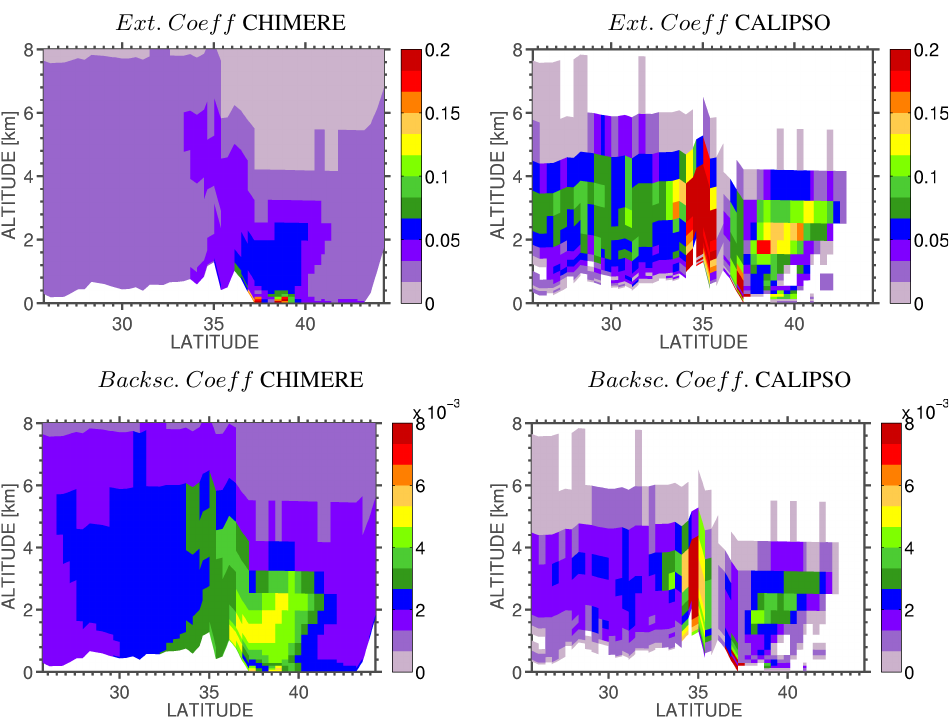
Fig. 13. Extinction (km − 1 ) and backscatter (km − 1 sr − 1 ) coefficient by CHIMERE (left) and CALIOP (right) for the nighttime portion of the orbit of the 9 July 2007. The CALIOP data are averaged into the model’s horizontal and vertical resolutions for comparison to the simulated profiles.